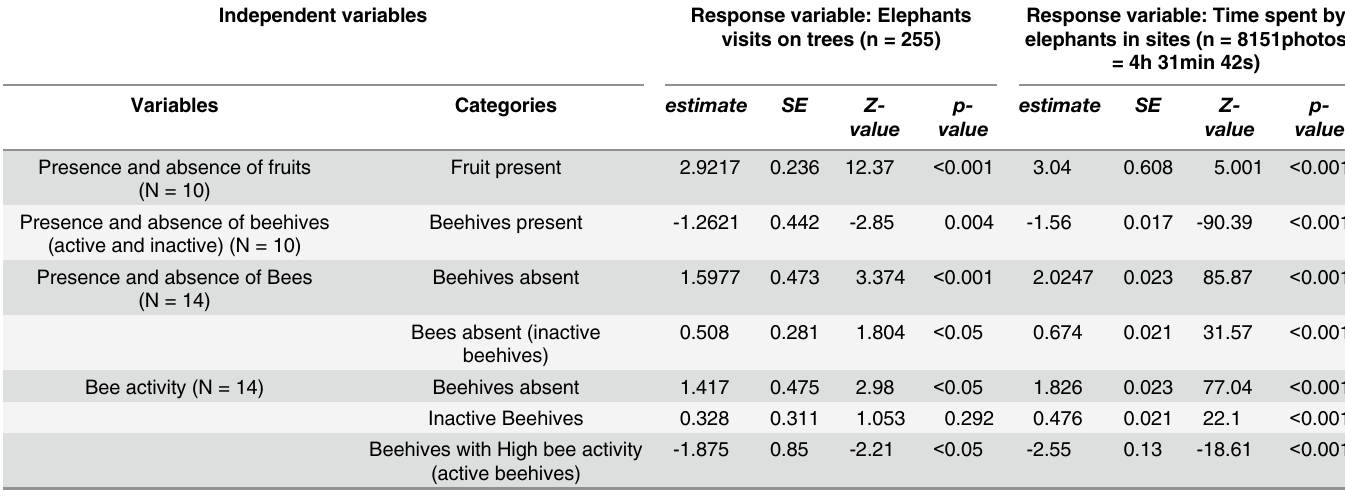
Table 1. Results of generalized linear models that examined the factors that explain the elephant behaviors. Independent